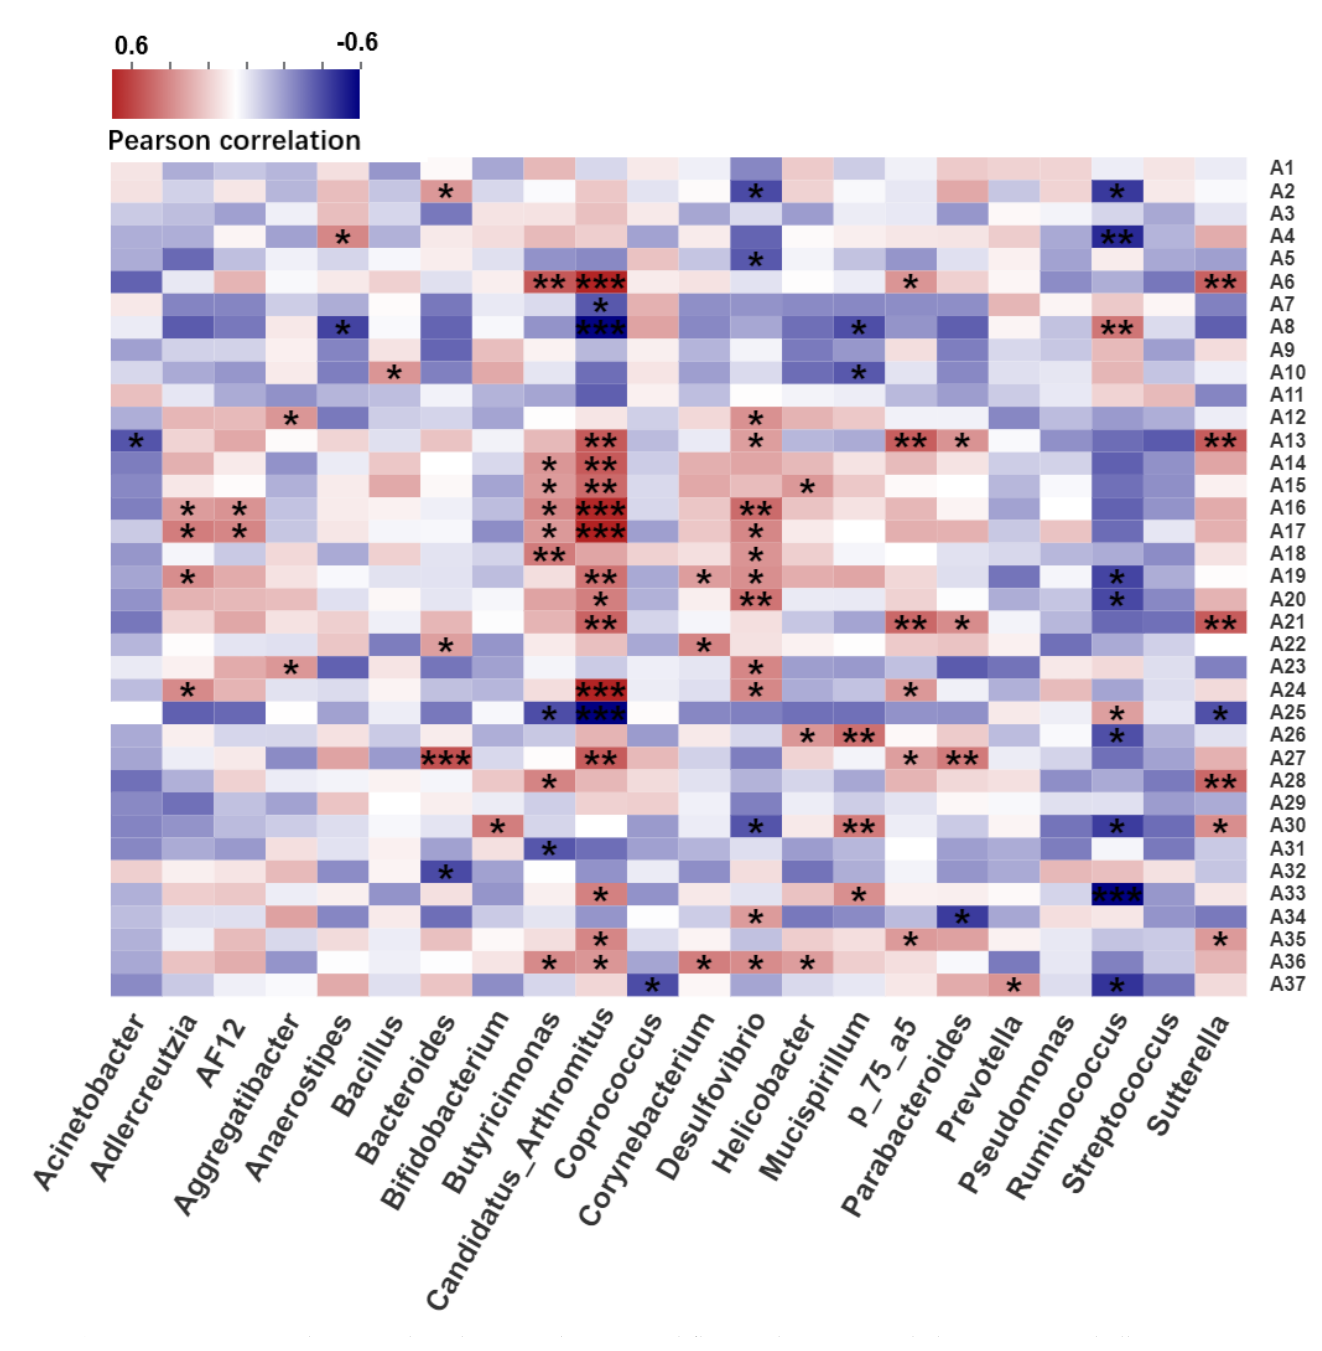
Figure 6. Pearson correlation analysis between the intestinal flora and serum metabolites. A1, 3–Methylhistamine; A2, Acetylcholine; A3, Histamine; A4, Spermidine; A5, Sphingosine; A6, Citrulline; A7, L –Arginine; A8, L –Glutamic acid; A9,